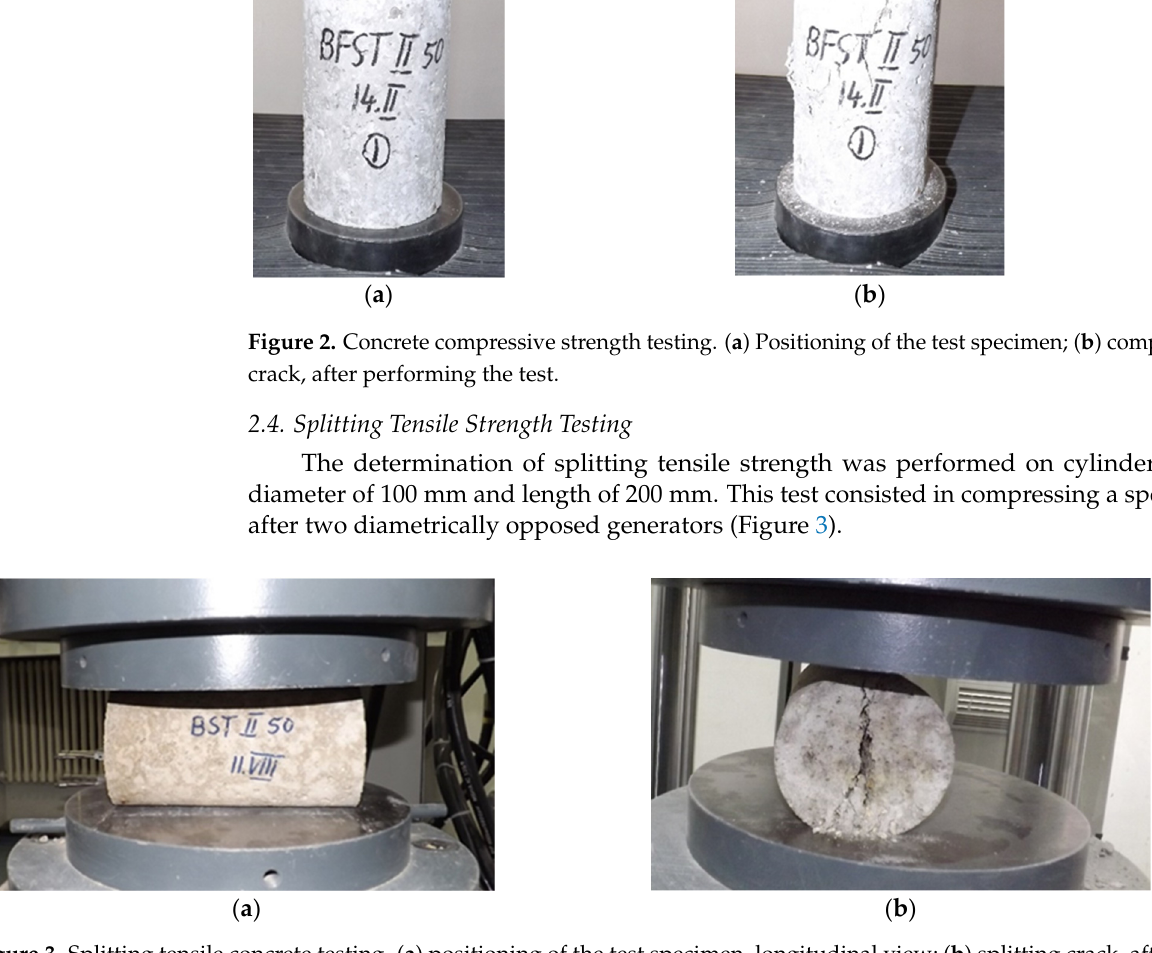
Figure 3. Splitting tensile concrete testing. ( a ) positioning of the test specimen, longitudinal view; ( b ) splitting crack, after performing the test.